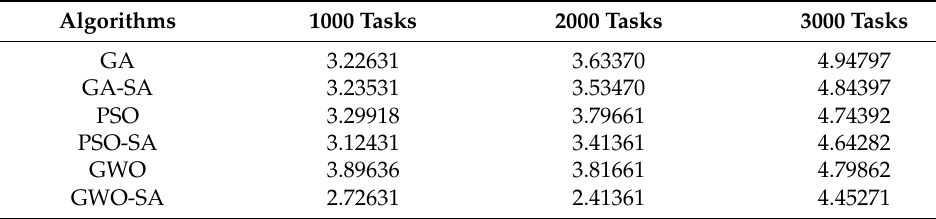
Table 6. Load Variations.